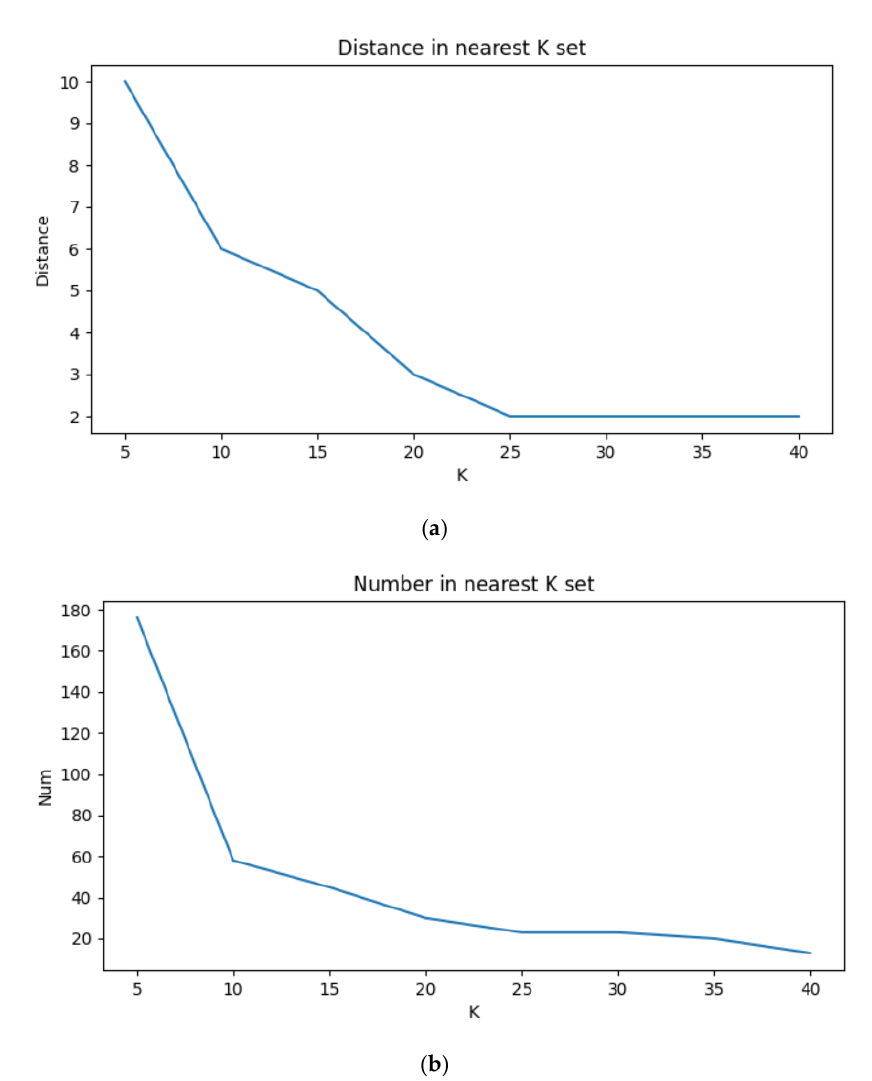
Figure 4. The variation diagram of the distance and number of K clustering. ( a ) Curve of the distance of the nearest K cluster to the warehouse as a function of K value; ( b ) Curve of the number of K-clusters nearest to the warehouse changing with K-value.